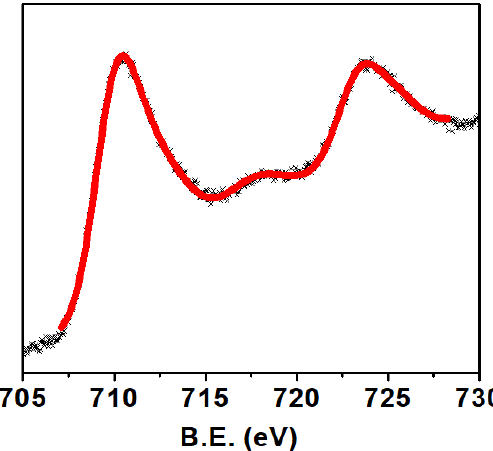
Figure 2. SEM image of Ca 2 Fe 2 O 5.